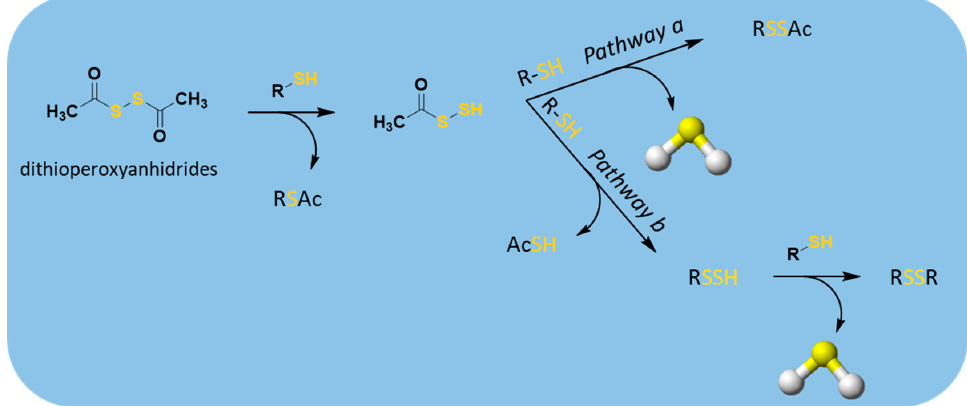
Figure 11. Proposed mechanism for H 2 S release from dithioperoxyanhydrides; R ′ -SH = cysteine or GSH.